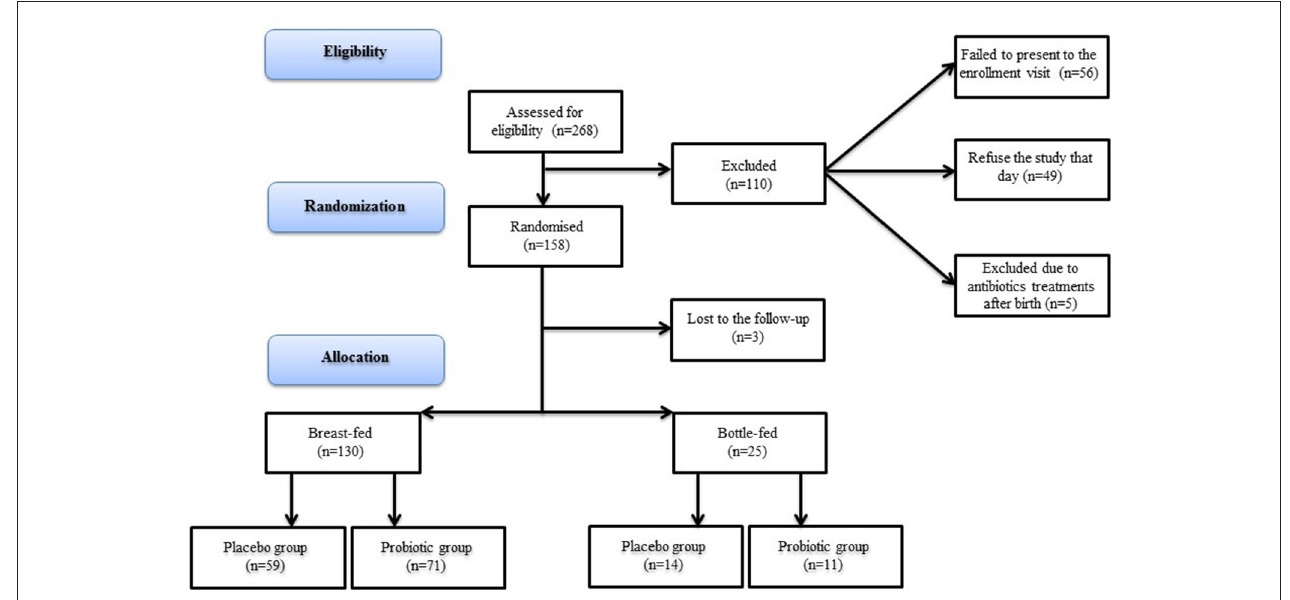
FIGURE 1 | Study flow